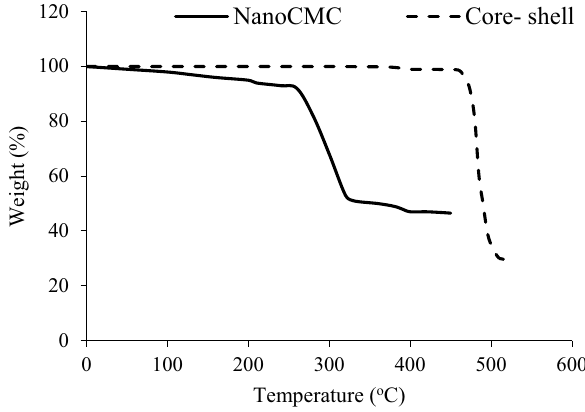
Fig. 5 a SEM image of core–shell nanocomposite, b TEM image of